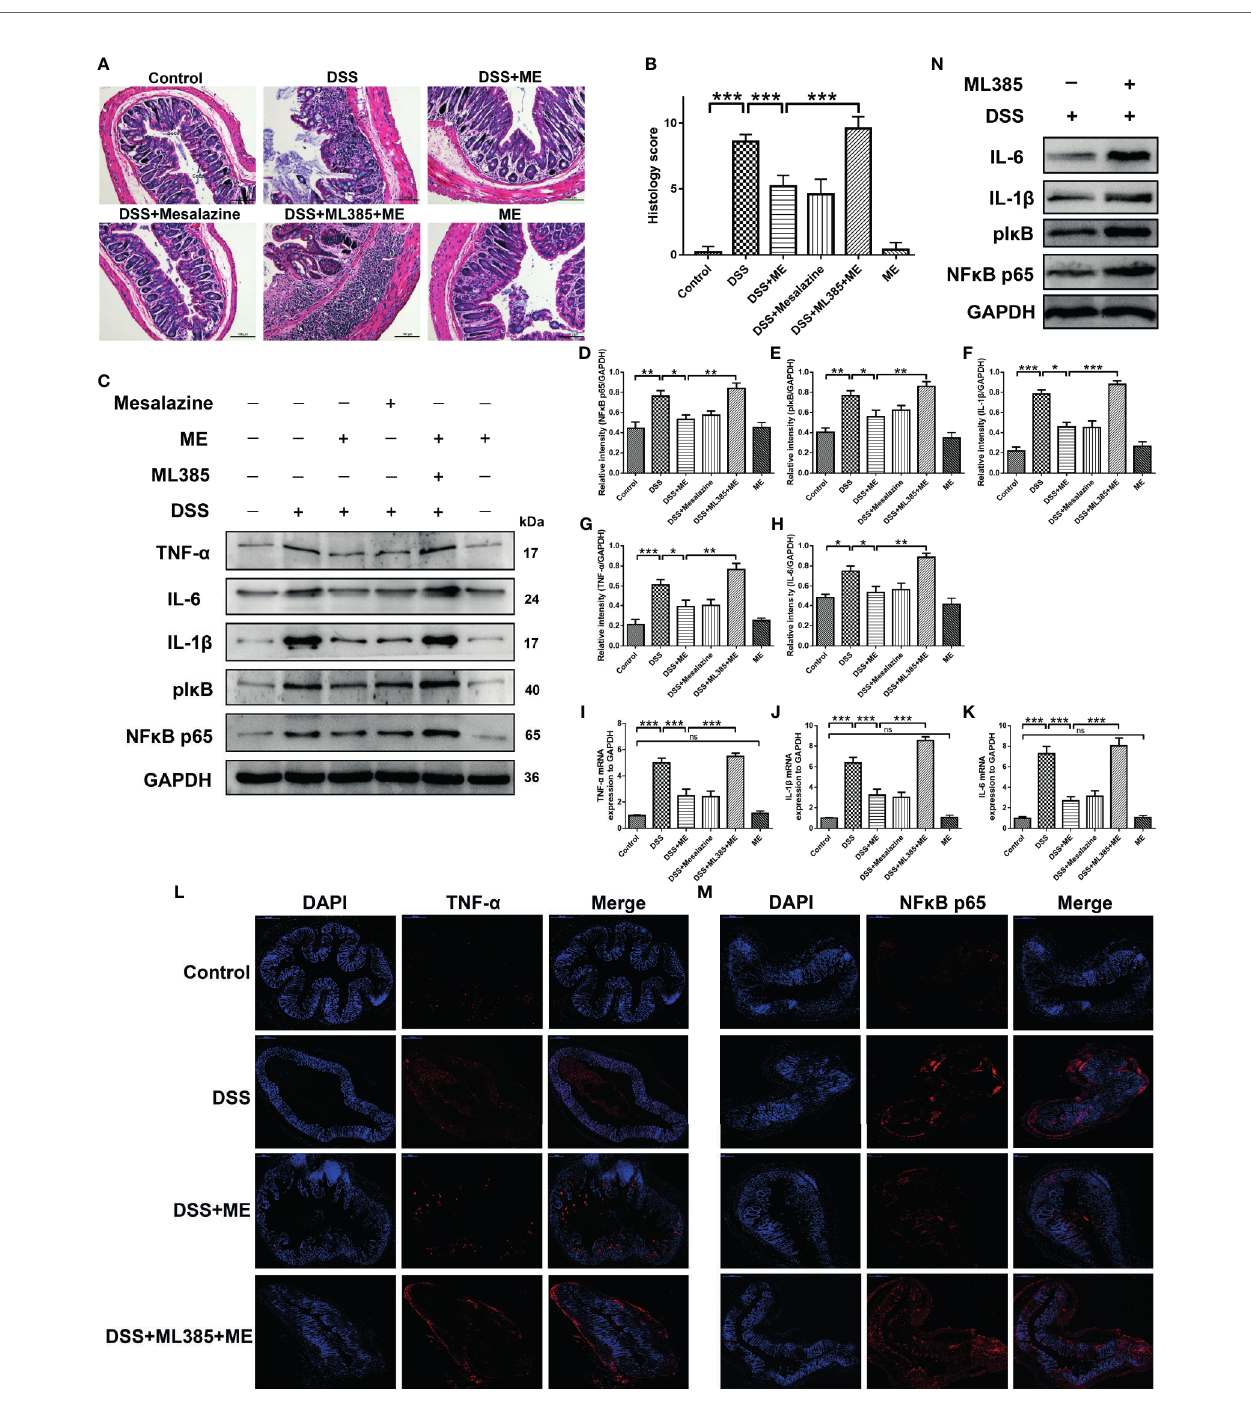
FIGURE 2 | ME alleviates DSS-induced colon damage and exhibits anti-in fl ammatory effects on DSS-induced colitis via Nrf2 activation. Mice were allocated to six groups (n=8 per group). After treatment, colons were removed, sectioned and then stained with H&E. The representative images of the stained sections (A) and histology scores (B) . Scale bar = 100 m m. CoEp, columnar epithelium; GoCe, goblet cell; InCe, in fl ammatory cell; InCr, intestinal crypt. The protein expression of pI k B, IL-1 b , IL-6, NF k B p65 (phospho S536) and TNF- a in colonic tissues was examined using Western blot analysis. Representative data are demonstrated (C) and the relative protein intensities of pI k B, IL-6, IL-1 b , NF k B p65 (phospho S536) and TNF- a were normalized to GAPDH (D – H) . The mRNA levels of TNF- a , IL- 1 b and IL-6 in colonic tissues (I – K) . To reveal different molecules (red), immunostaining was conducted on the colon tissue section (L, M) . To counterstain the slides, DAPI (blue), an inverted fl uorescence microscope was used for imaging (×200). Data are presented as mean ± SD. ∗ P < 0.05, ∗∗ P < 0.01, and ∗∗∗ P < 0.001; ns, no signi fi cance. (N) The protein expression of pI k B, IL-1 b , IL-6 and NF k B p65 (phospho S536) in colonic tissues was examined using Western blot